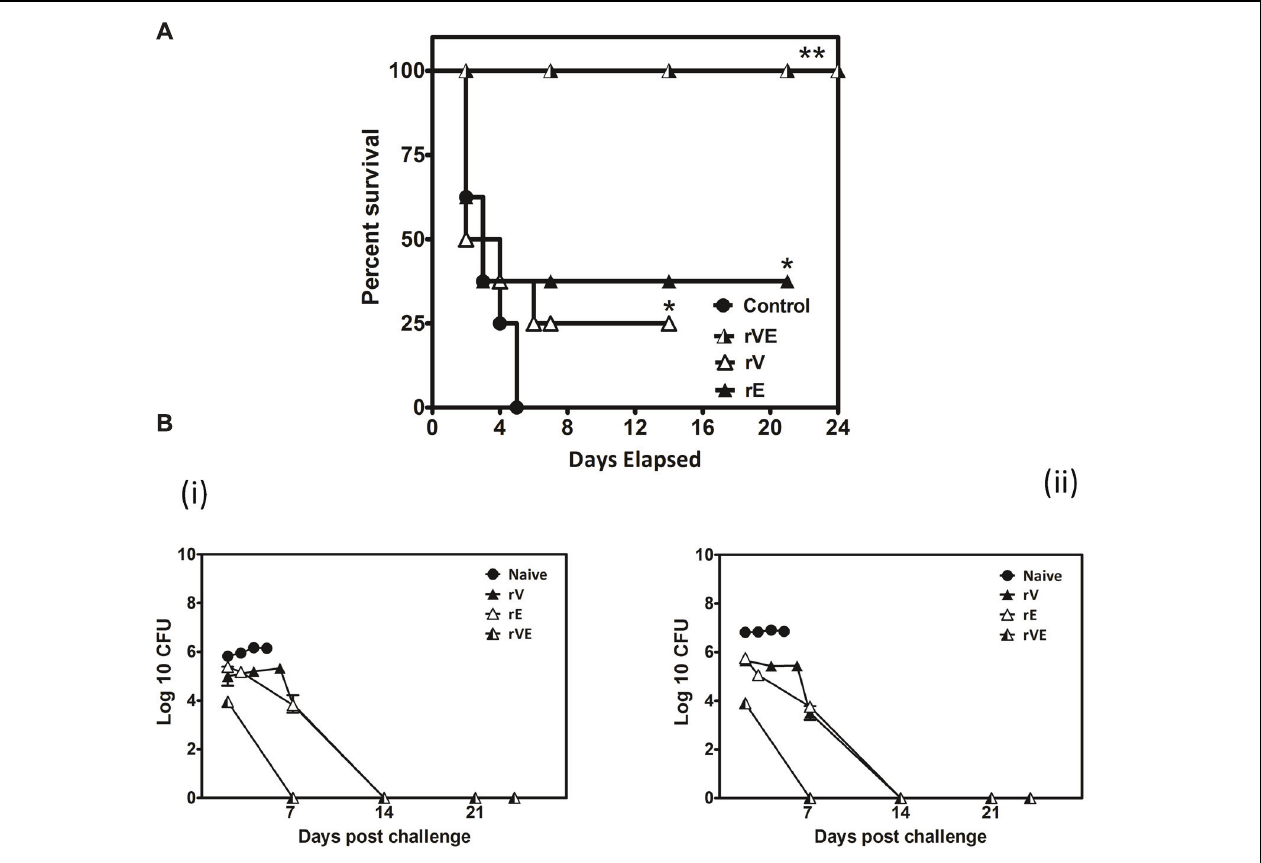
FIGURE 6 | Actively vaccinated mice and sham vaccinated mice were challenged with Y. enterocolitica 8081 to assess the memory immune protection. (A) Group of BALB/c mice scheduled immunized for 42nd day with 50 μ g of recombinant proteins (rV, rE, and rVE) and left uninfected for 120 days. After incubation of 120 days mice were IP injected with 10 8 CFU of Y. enterocolitica and survival was monitored for 24 days. Sham immunized mice were considered as control. Data represented as the percentage survival calculated by Kaplan–Meier method using Graphpad Prism5. (B) Bacterial burden in immunized and sham immunized mice challenged with Y. enterocolitica 8081. The analysis of total Colony Forming Units (CFU) in liver (i), spleen (ii), were performed at different time points (day 2, 7, 14, and 24) post challenge. Data pooled from 2 to 4 biological replicates in two statistical repeats were analyzed by Univariate method applying Dunnett’s and Tukey’stest. ∗ P < 0.05; ∗∗ P < 0.01; ∗∗∗ P <